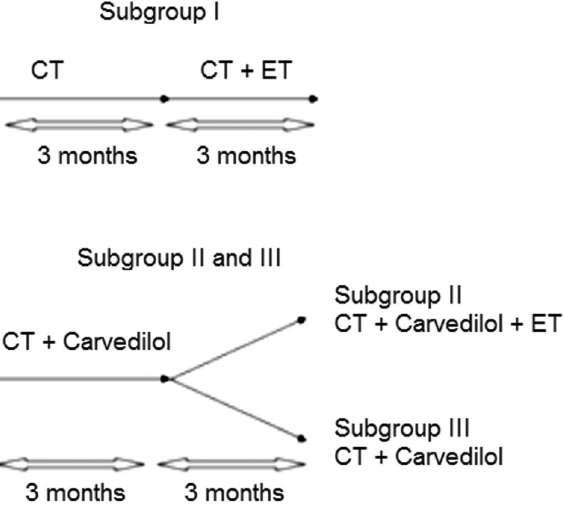
Figure 1. Study design. CT: conventional treatment; ET: exercise